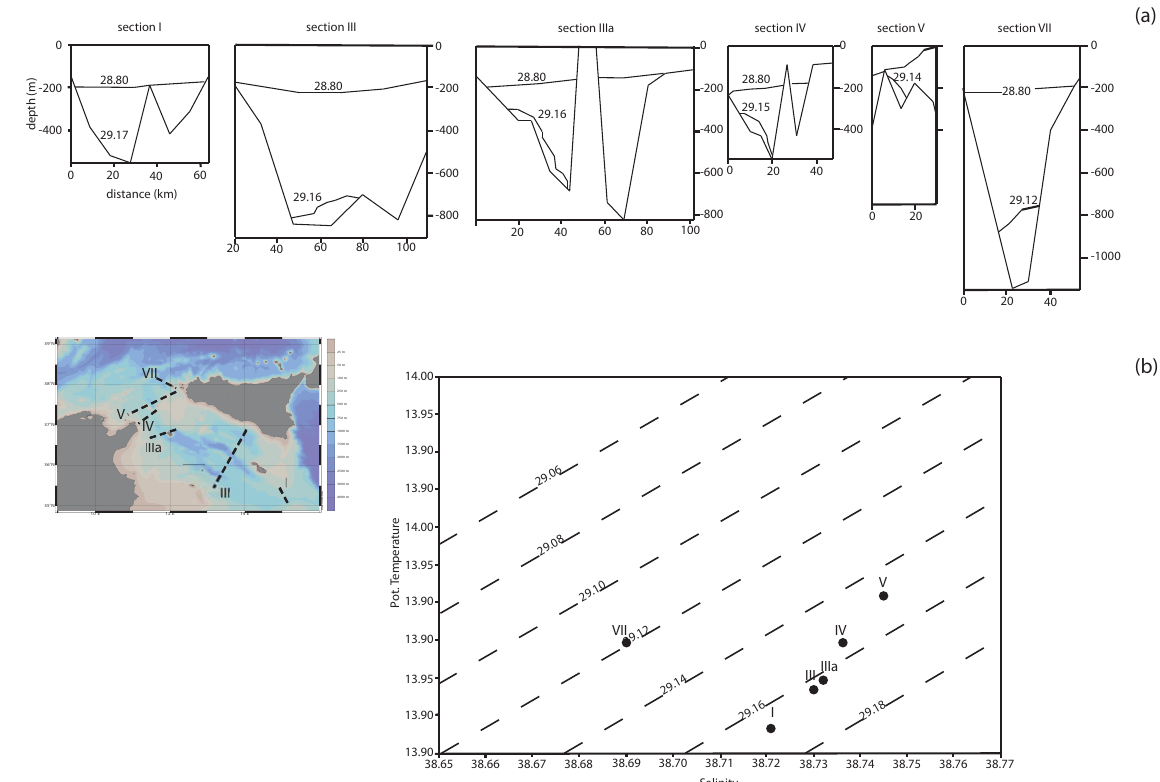
Figure 4. MATER IV cruise (April–May 1998): (a) characteristic isopycnal cross sections between surface Atlantic water, LIW, and EMDW. In these sections, Tunisia is on the left side. Note that, in section III, the EMDW flows only in the western passage of the cross section; interfacial slope modification is also visible in sections III, IV, and V (b) Evolution of θ − S values of EMDW close to the bottom. From Astraldi et al.